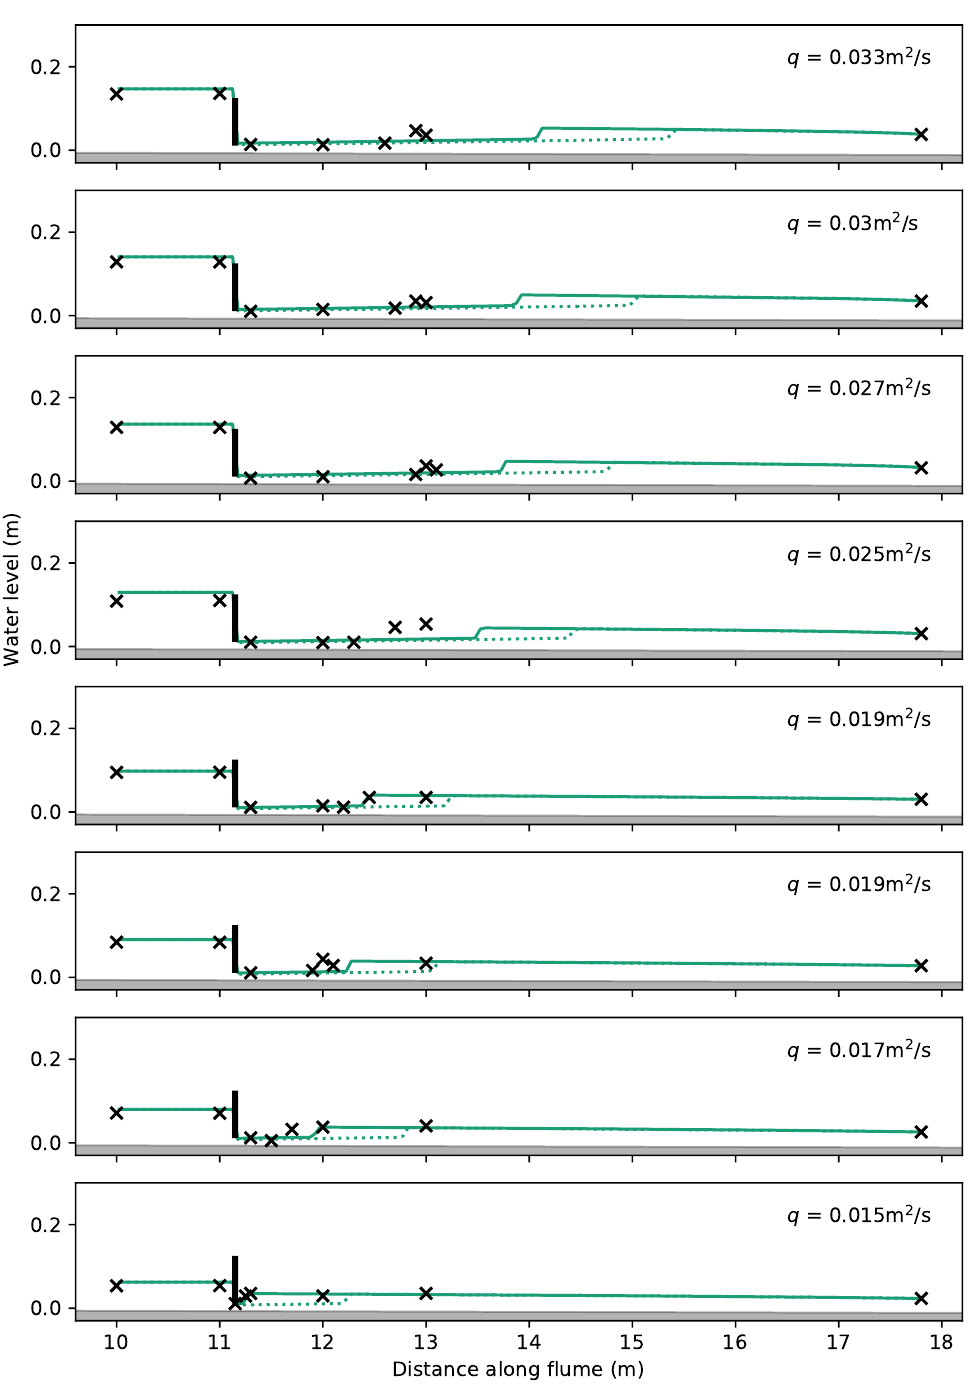
Figure A7. Results for configuration